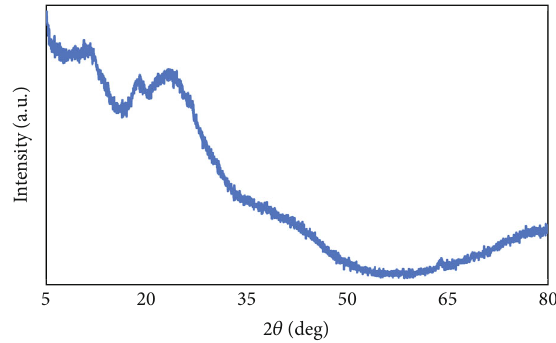
Figure 4: X-ray di ff raction (XRD) pattern of the as-synthesized Cs-Al NDs.